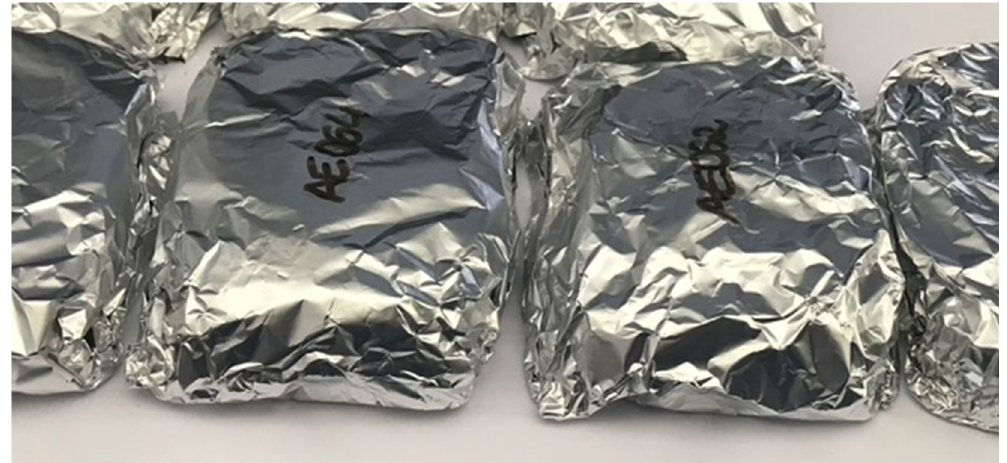
Figure 2. Samples wrapped in aluminum foil prepared for torrefaction.